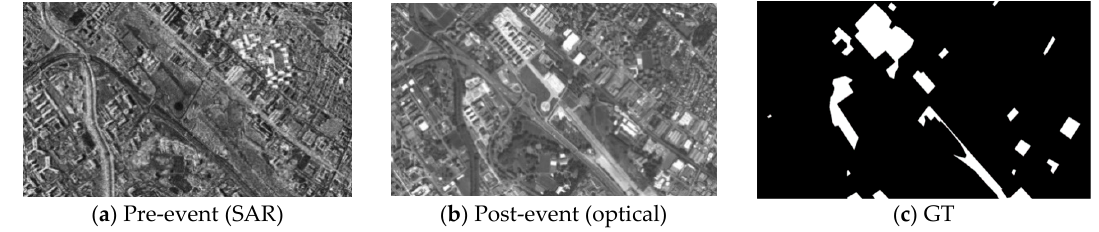
Figure 14. Image pair-4: TerraSAR-X / Pleiades.